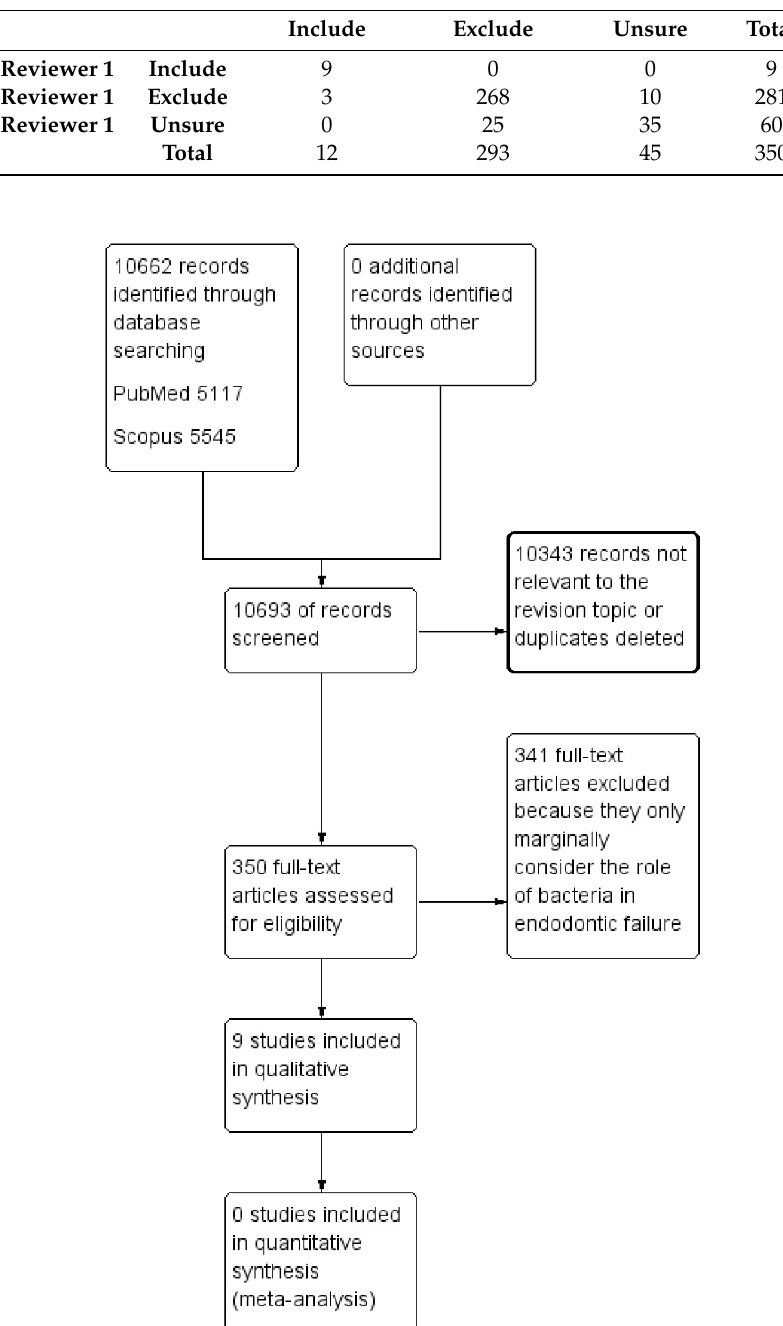
Figure1. Figure 1. The flow chart describing the research methodology following the PRISMA protocol guidelines.